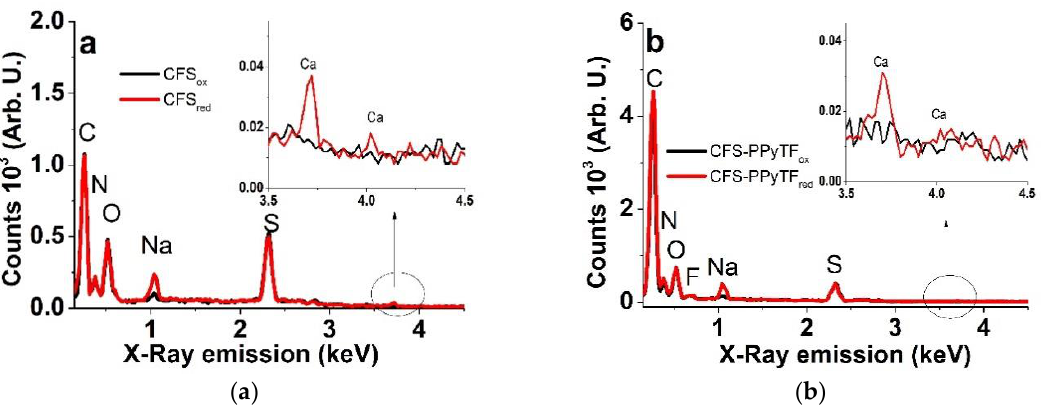
Figure 2. Energy-dispersive X-ray (EDX) spectra of oxidized (5min, 0.65 V, black line) and reduced (5 min at −0.6 V, red line) cross sections of samples of ( a ) CFS and ( b ) CFS-PPyTF with insets showing calcium evolution.